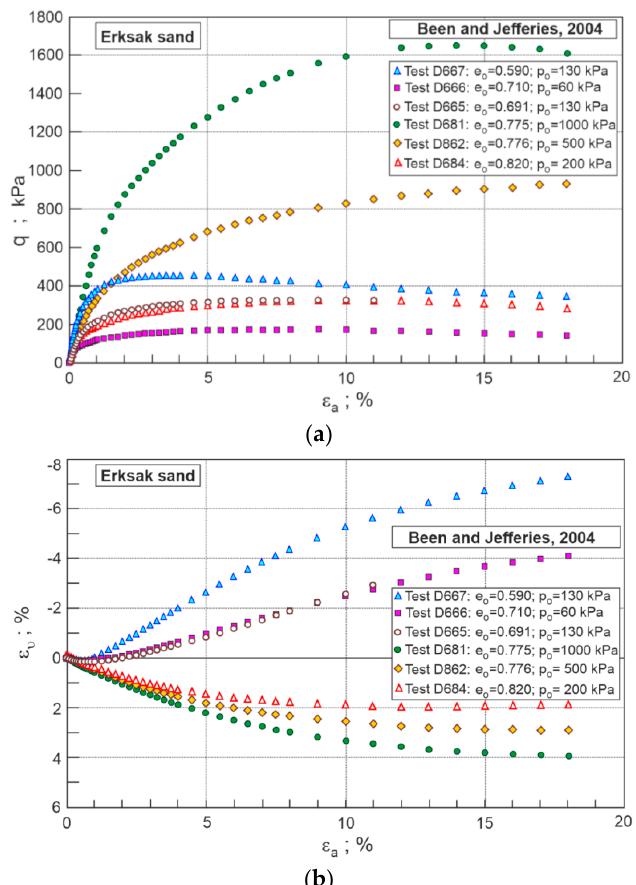
Figure 2. Triaxial compression test results for Erksak sand: ( a ) deviator stress–axial strain relationship; ( b ) volume strain–axial strain relationship.